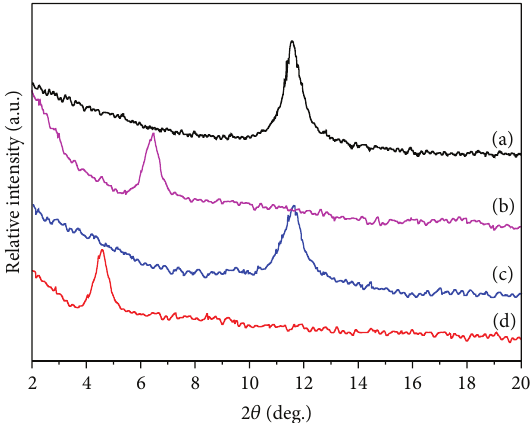
Figure 4: XRD patterns of (a) Zn/Al-CO 32− -LDH, (b) Zn/Al- HNOB − -LDH, (c) Zn/Al-CO 32− -LDH/SBS modified asphalt, and (d) Zn/Al-HNOB − -LDH/SBS modified asphalt.